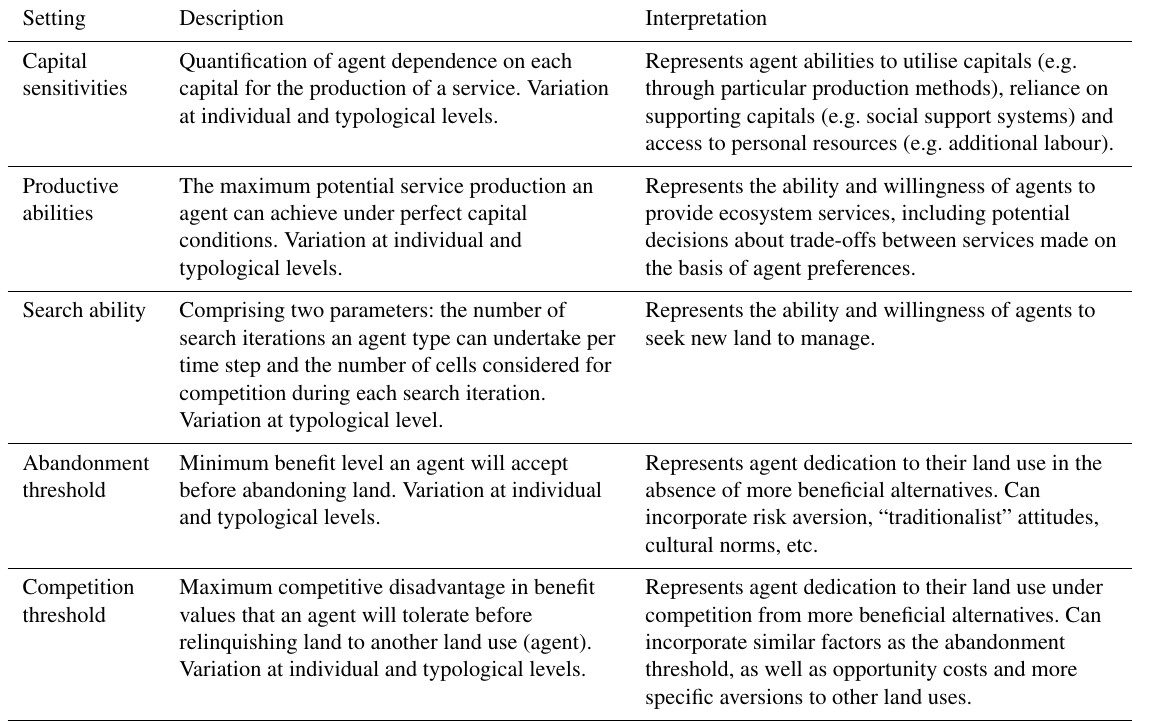
Table 3. Identities and descriptions of behavioural parameters used in CRAFTY-EU.